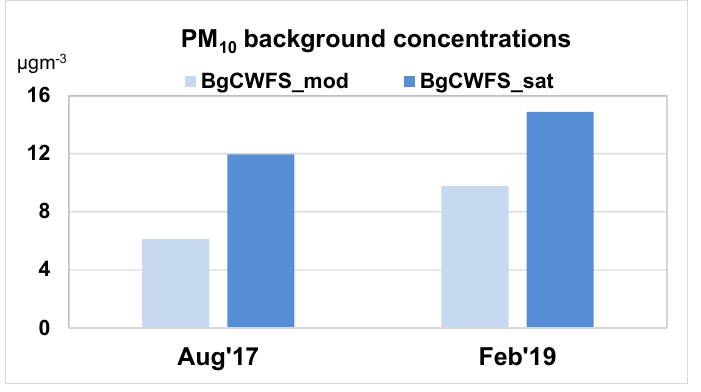
Figure 11. Monthly mean PM 10 background concentrations for the city of Plovdiv from BgCWFS_mod and BgCWFS_sat.